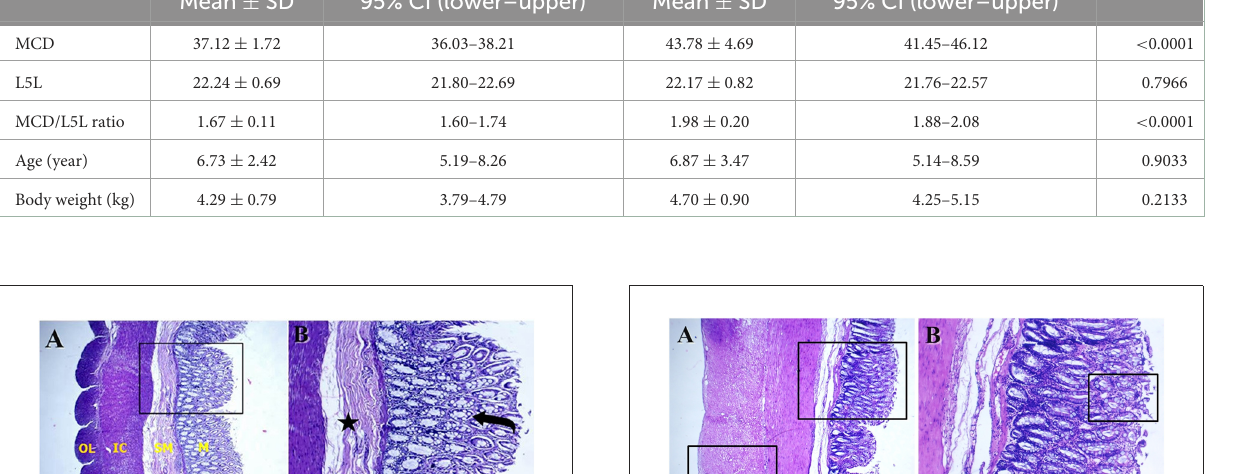
TABLE 3 Descriptive analysis of MCD, L5L, MCD/L5L ratio, age, and body weight for the cats had confirmed idiopathic megacolon with either duration of constipation/obstipation < 6 months ( n = 12) or ≥ 6 months ( n = 18). Variables